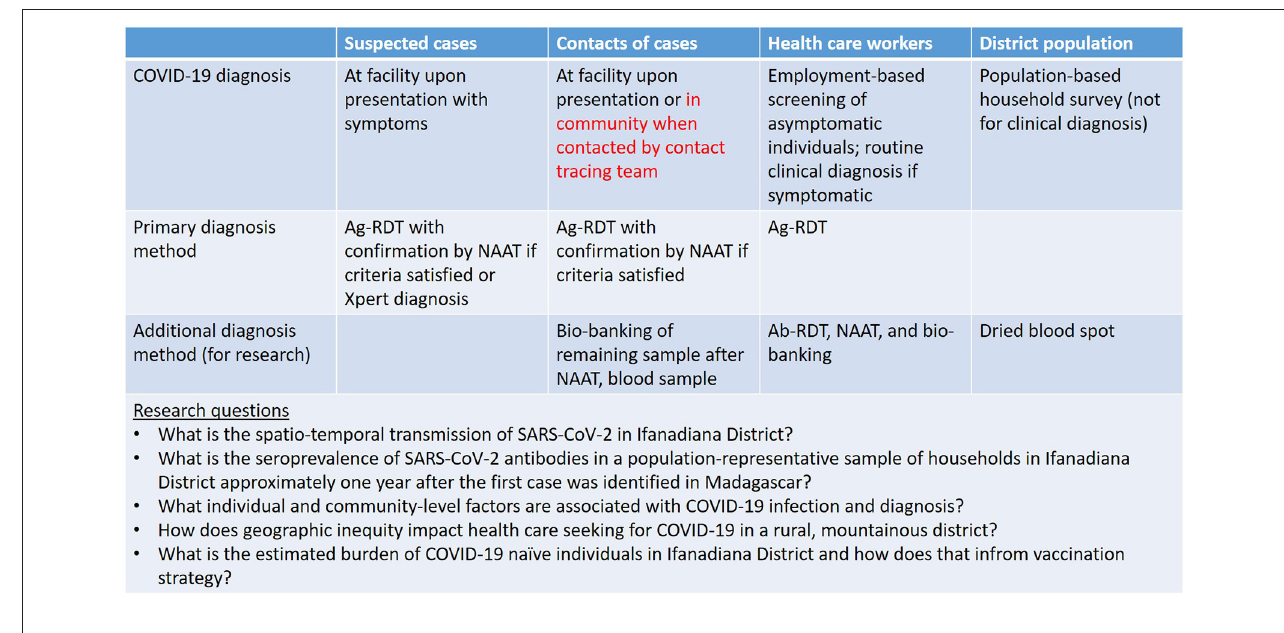
FIGURE 4 | Key populations for COVID-19 research activities and data collection to inform